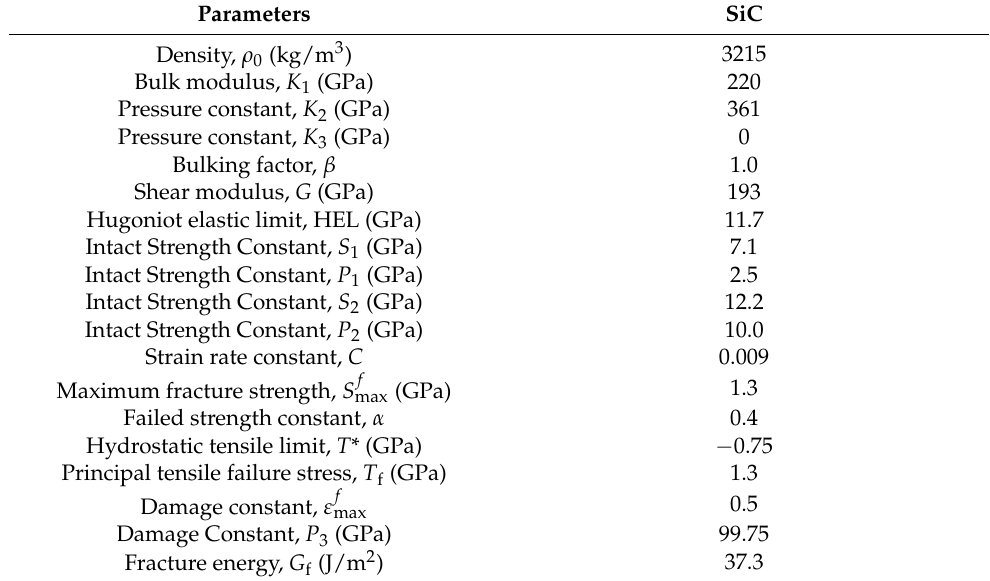
Table 1. JH-1 material model constants for SiC